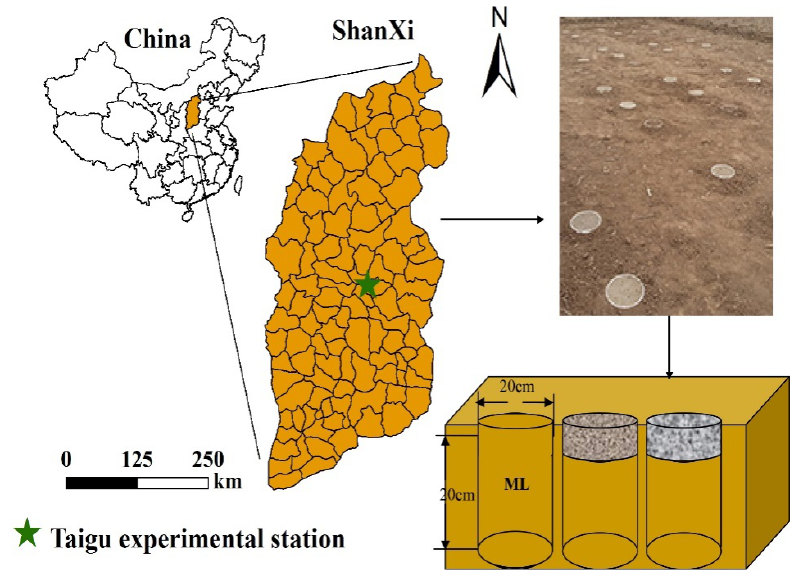
Figure 1. The location of the Taigu Water Balance Experimental Field and schematic diagram of the micro-lysimeter in the field. micro-lysimeter in the field. Table 1. Properties of the soils in the micro-lysimeters. Table 1. Properties of the soils in the